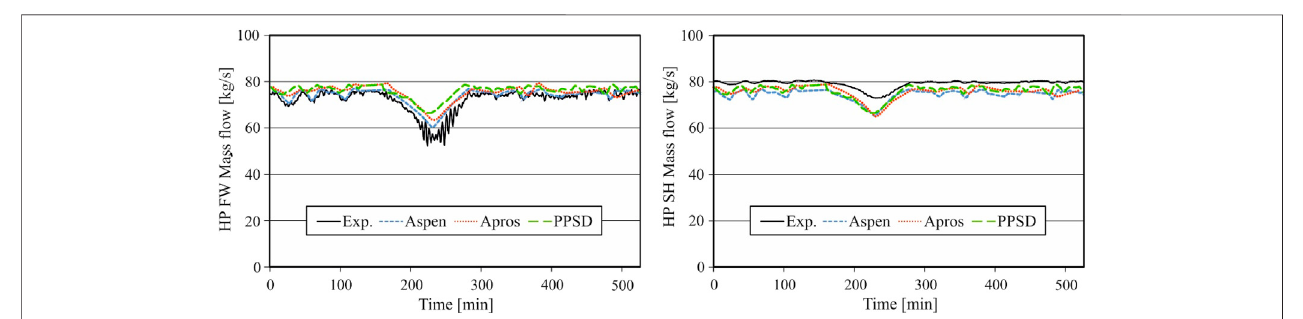
FIGURE 8 | Operational data and simulated results of the high-pressure feed water and steam mass fl ow rates using three different software during a load change scenario (source Ata et al., 2020).